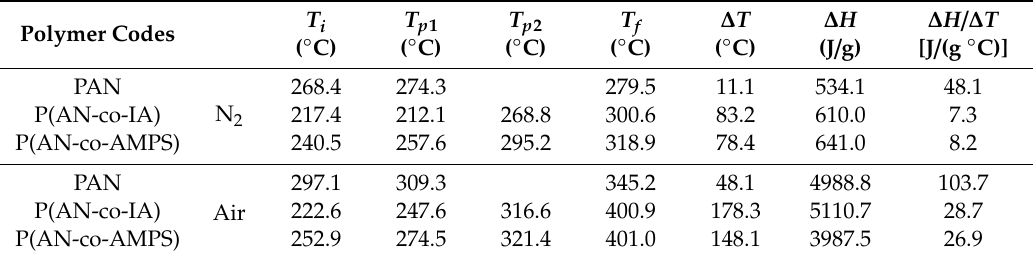
Figure 3. Differential scanning calorimetry (DSC) curves of PAN, P(AN-co-IA), and P(AN-co-AMPS) nanofibers under ( a ) N 2 atmosphere and ( b ) air atmosphere. Table 1. DSC results of PAN, P(AN-co-IA), and P(AN-co-AMPS) nanofibers under N 2 and air atmospheres,